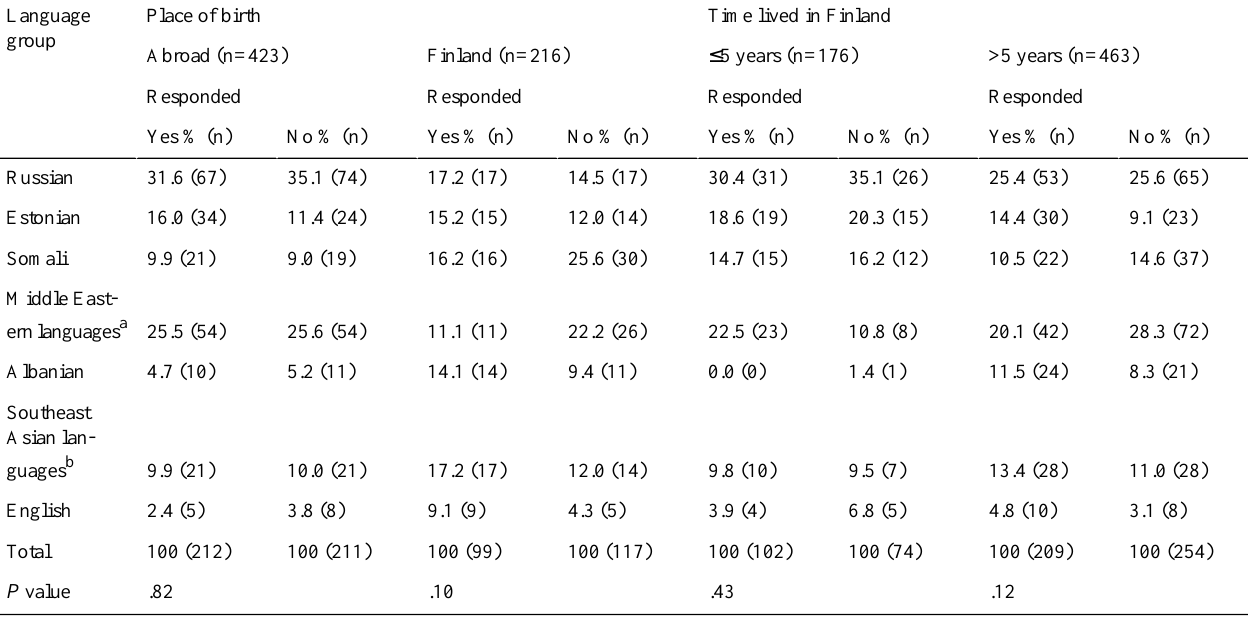
Table 3. Distribution of language groups among respondents and nonrespondents according to place of birth and time lived in Finland, % (n), and P value for differences between respondents and